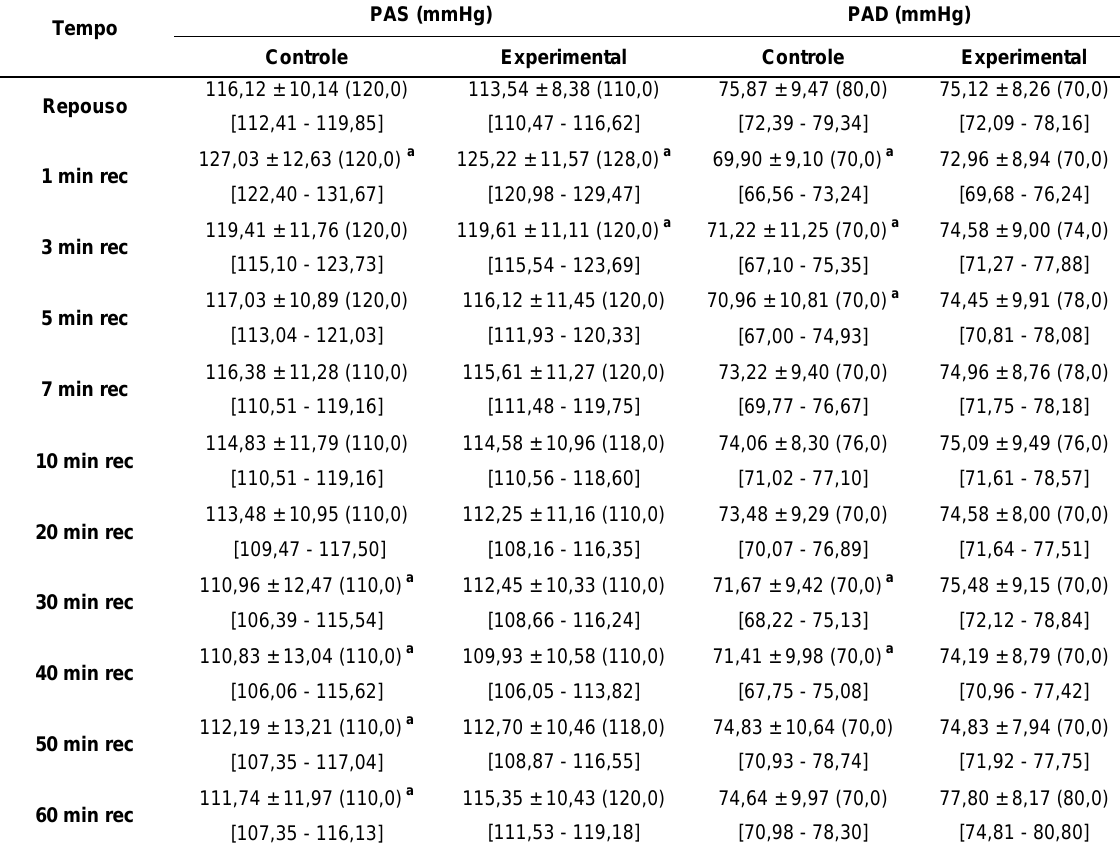
Tabela 4- Valores médios, seguidos dos seus respectivos desvios-padrão, mediana e intervalo de